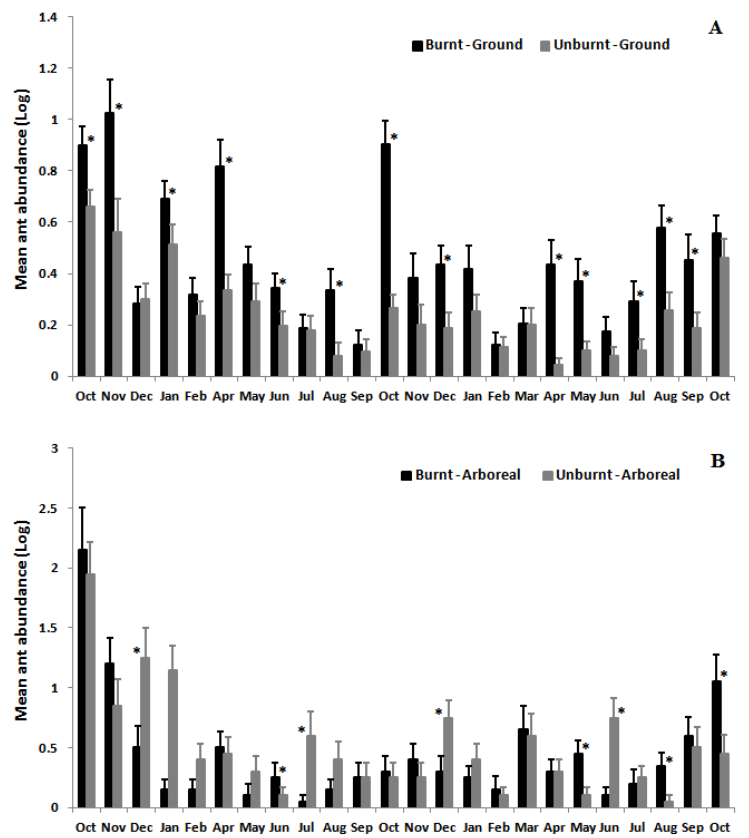
Figure 4. Variation in mean abundance of ground ( A ) and arboreal ant species ( B ) at Itacolomi State Park over two years in burnt (black bars) vs. unburnt (grey bars) areas. Asterisks indicate significant differences among months ( p < 0.05).